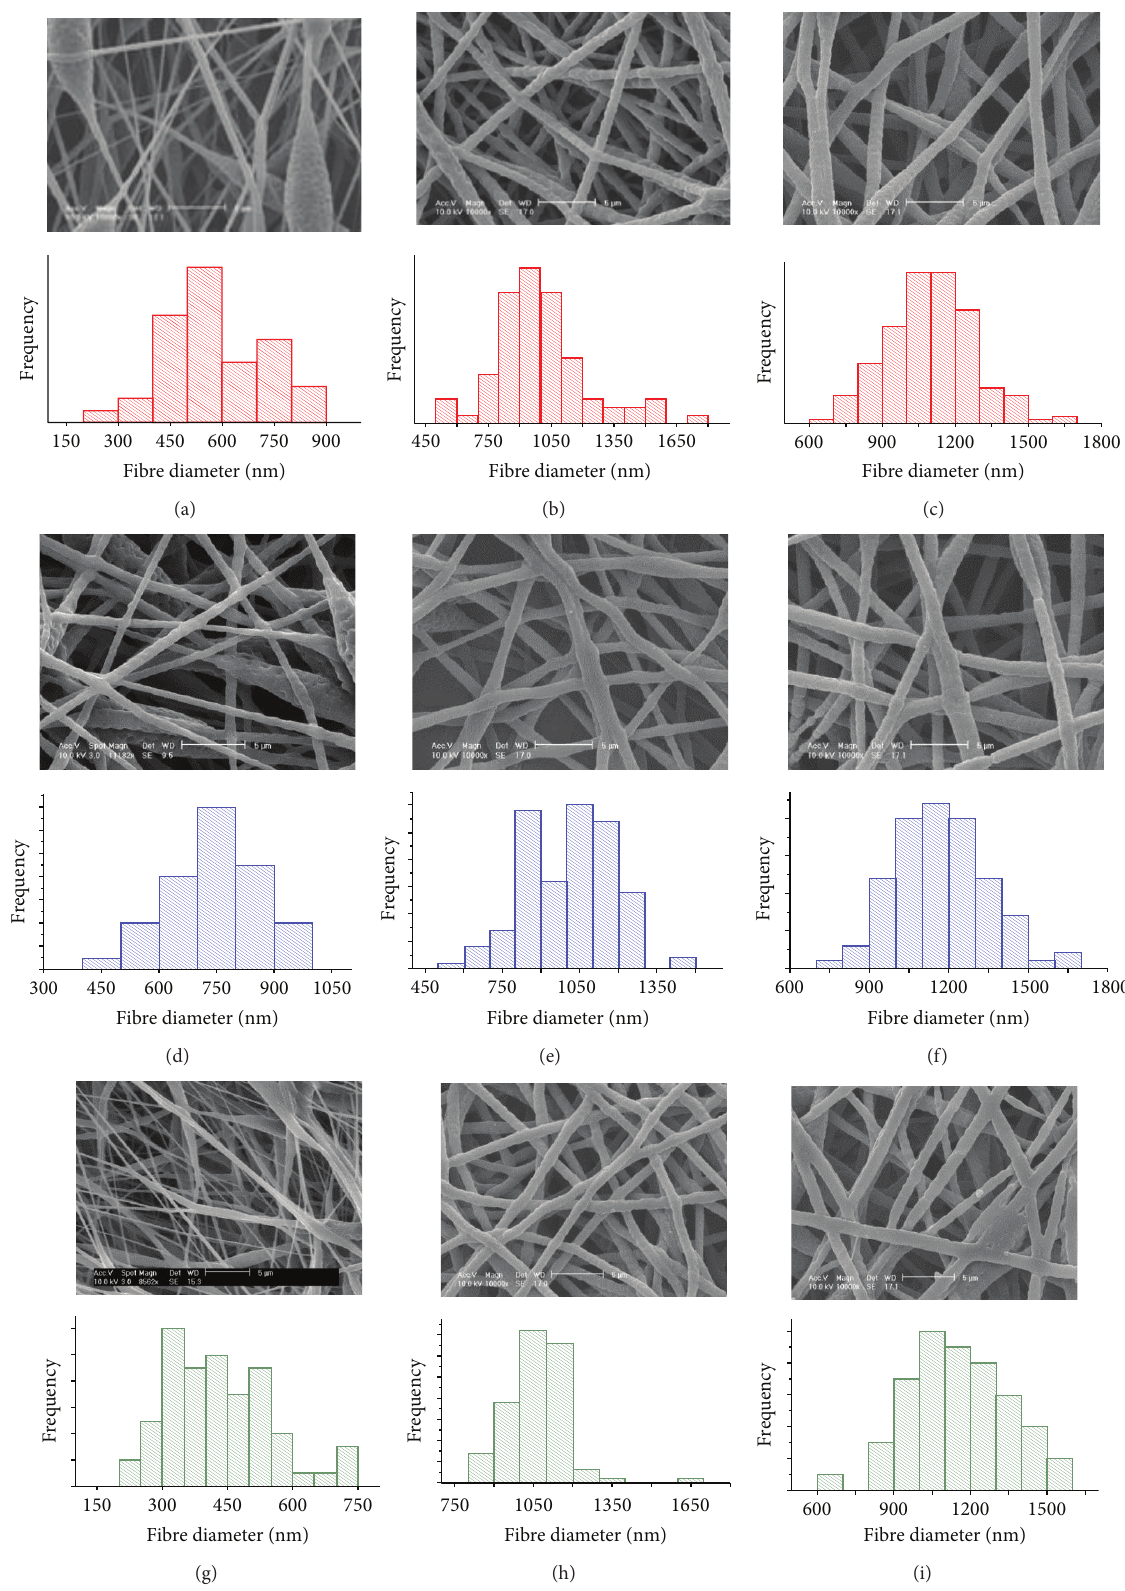
Figure 7: SEM images of PHB nanofibres using different concentrations of PHB from various carbon sources: (a), (b), and (c) = 1.5%, 2%, and 2.5% G-PHB; (d), (e), and (f) = 1.5%, 2%, and 2.5% O-PHB; (g), (h), and (i) = 1.5%, 2%, and 2.5% R-PHB,